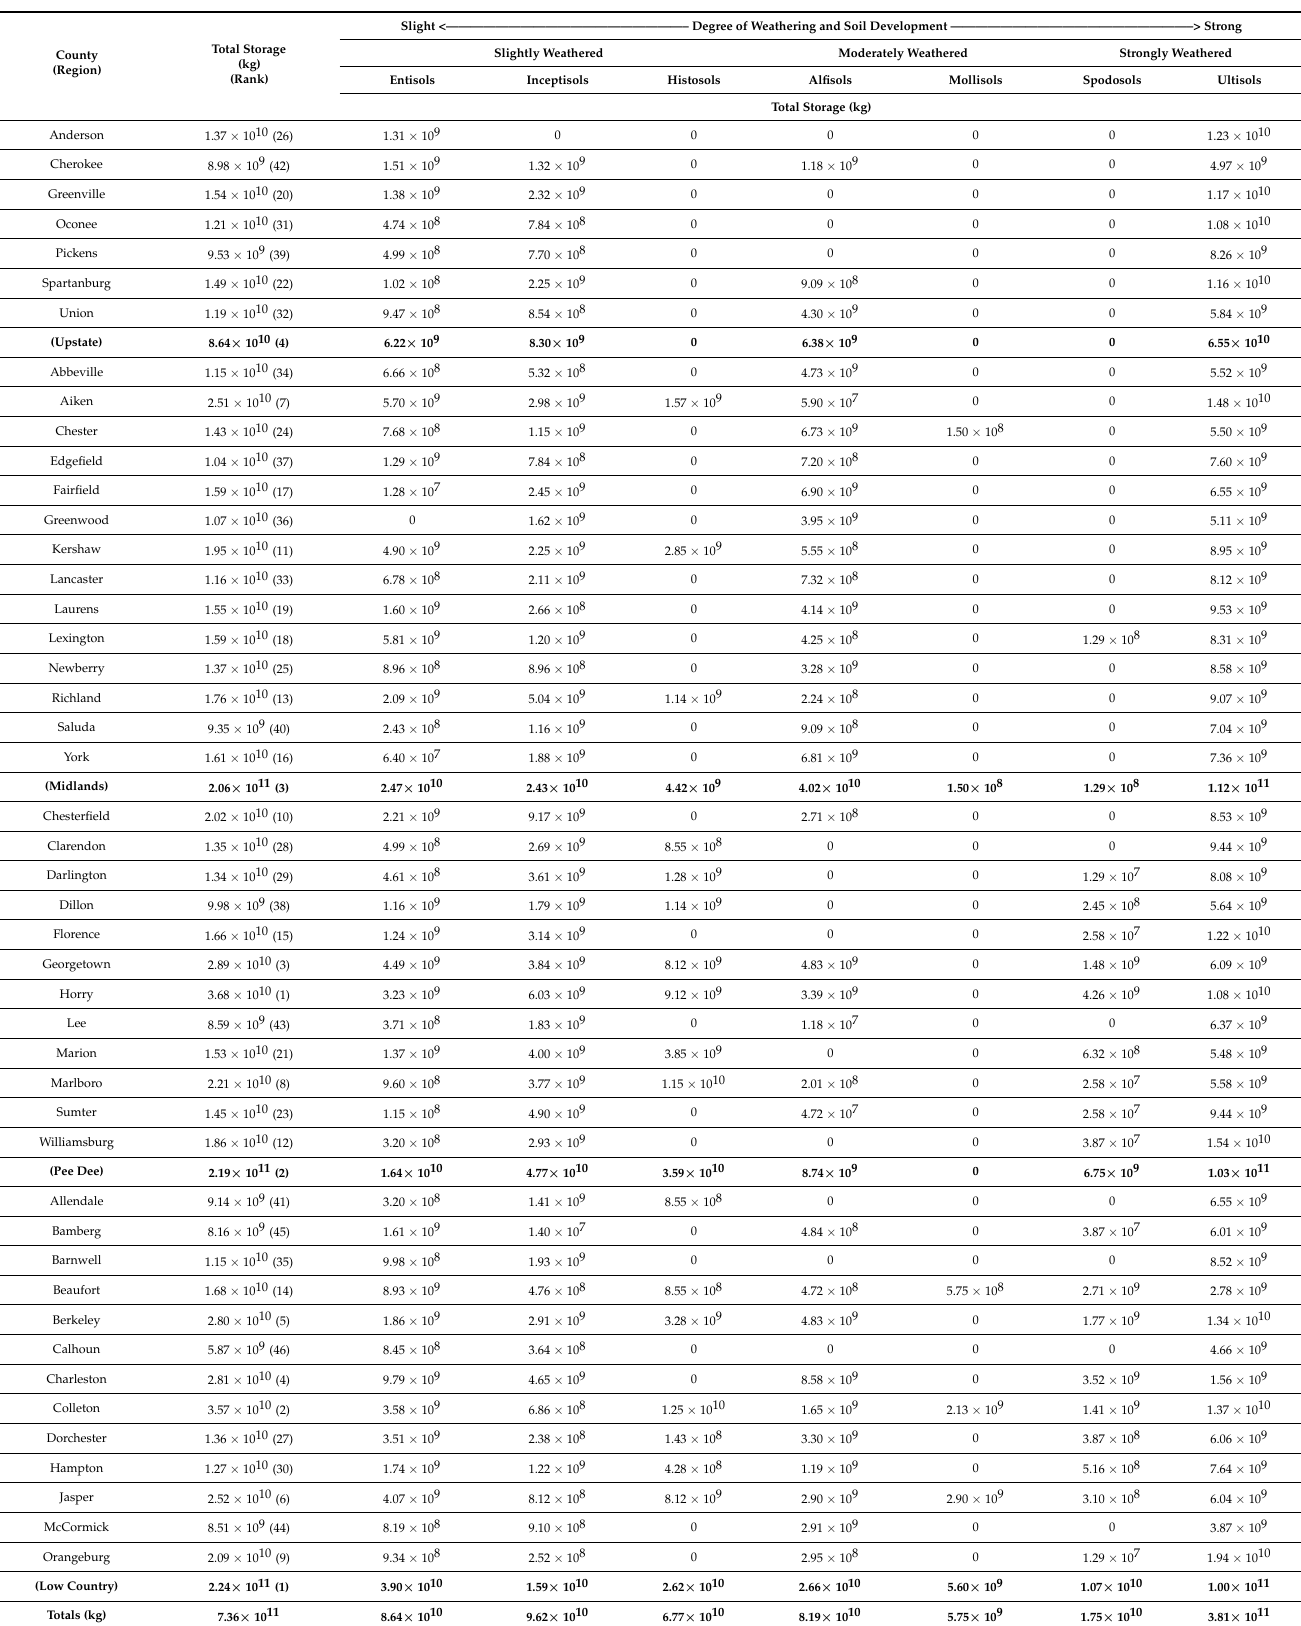
Table 9. Mid-point total soil carbon (TSC) storage by county, region, and soil order for the state of South Carolina (U.S.A.), based on mid-point (TSC) contents in the upper 2 m based on data from Guo et al. 2006 [18].